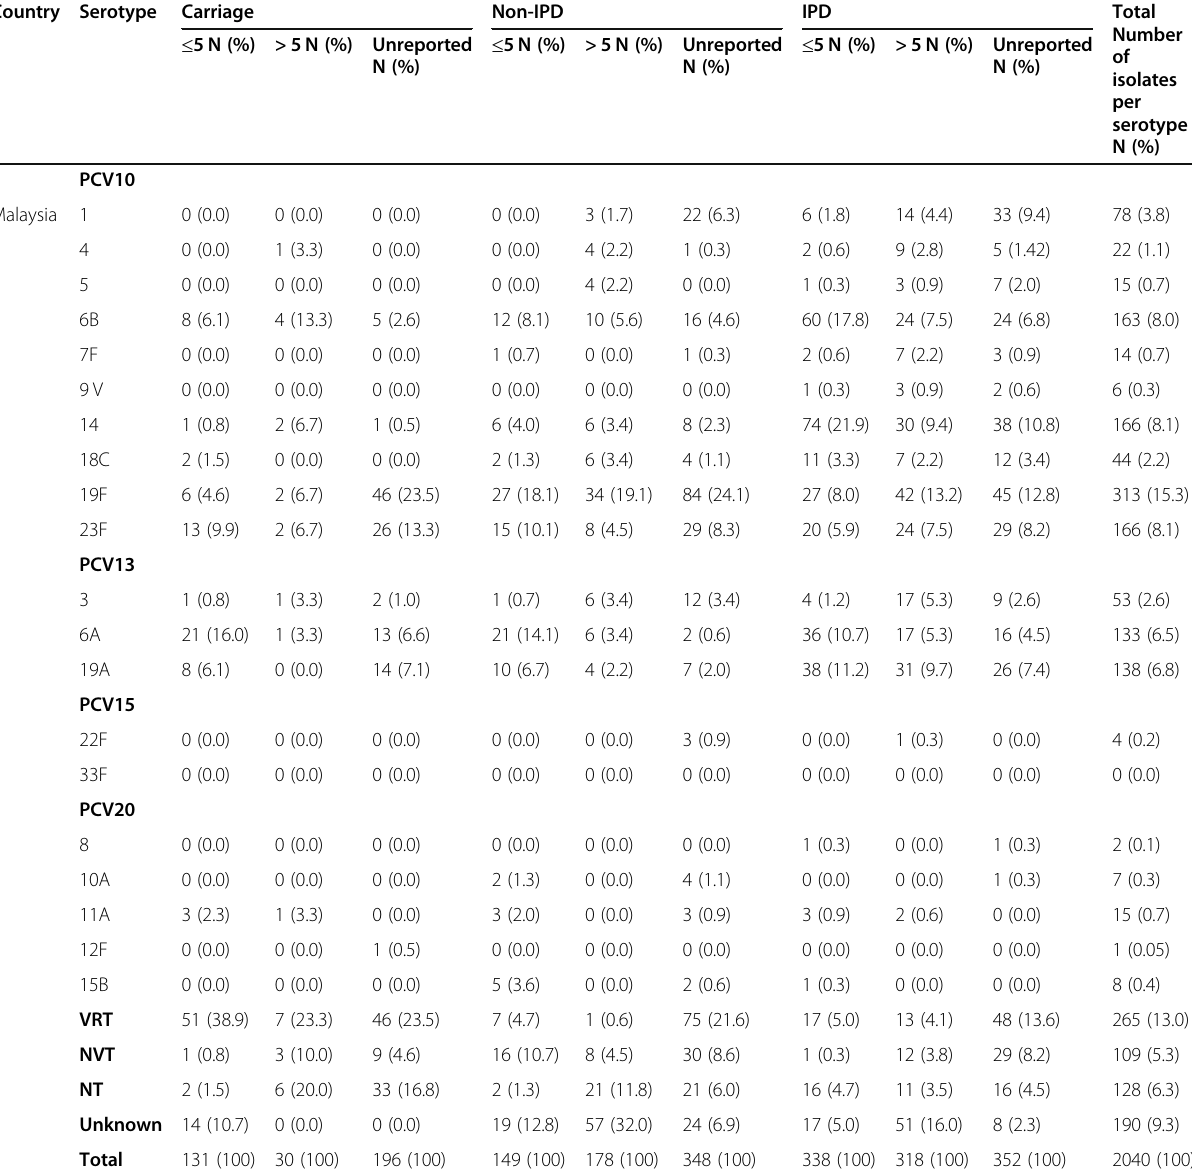
Table 2 Serotype counts across carriage, non-IPD and IPD studies Country Serotype Carriage